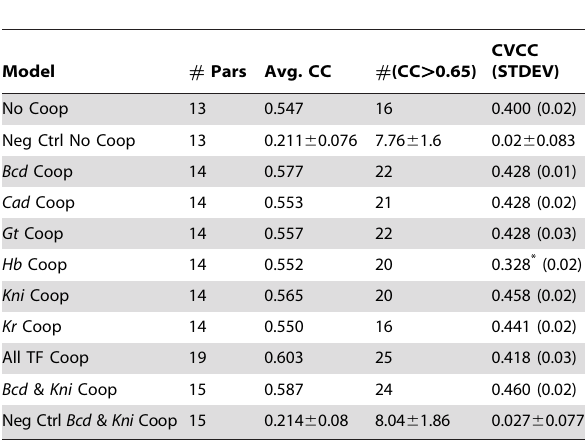
Table 2. Evaluation of the DirectInt model with various cooperativity